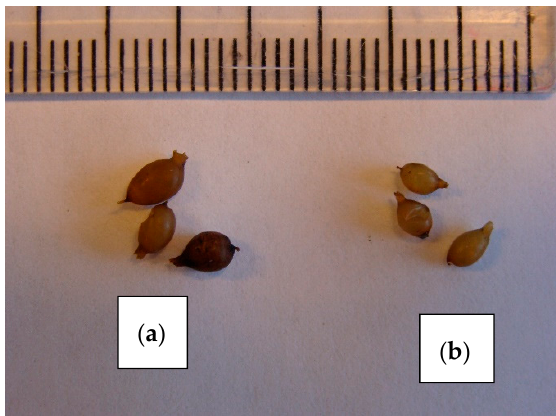
Figure 9. Cocoons produced by E. fetida : ( a ) Owinema, ( b ) control.